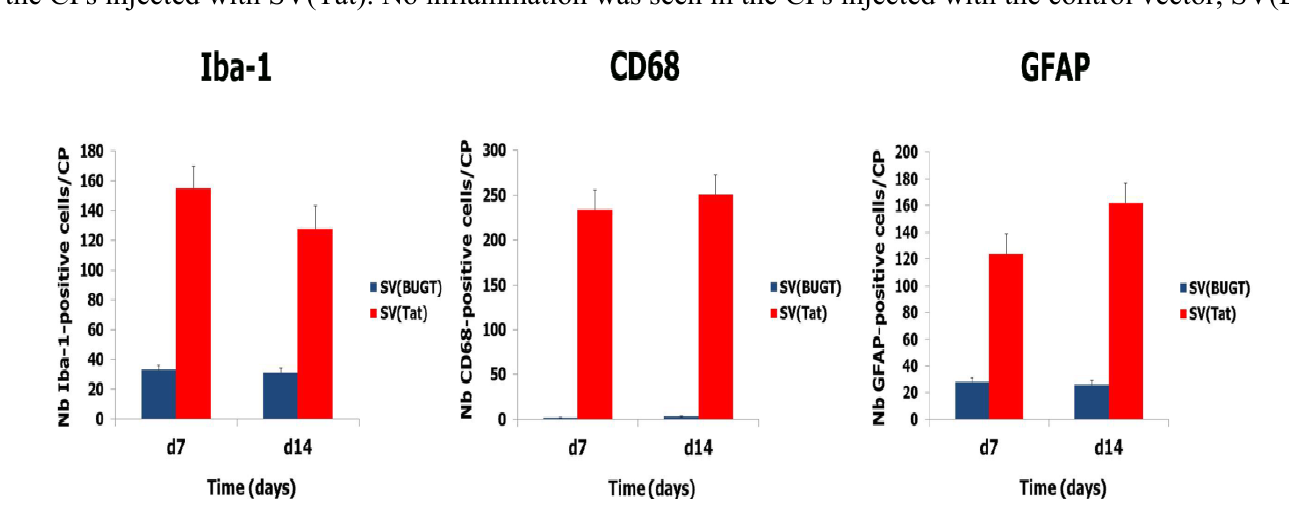
Figure 4. Injection of SV(Tat) in the caudate-putamen (CP) induces neuroinflammation. Brains were harvested one and two weeks after injection of SV(Tat) in the CP. Increased numbers of microglial cells (Iba-1- and CD68-positive cells) and astrocytes (GFAP-positive cells) were observed in the CPs injected with SV(Tat). No inflammation was seen in the CPs injected with the control vector, SV(BUGT).